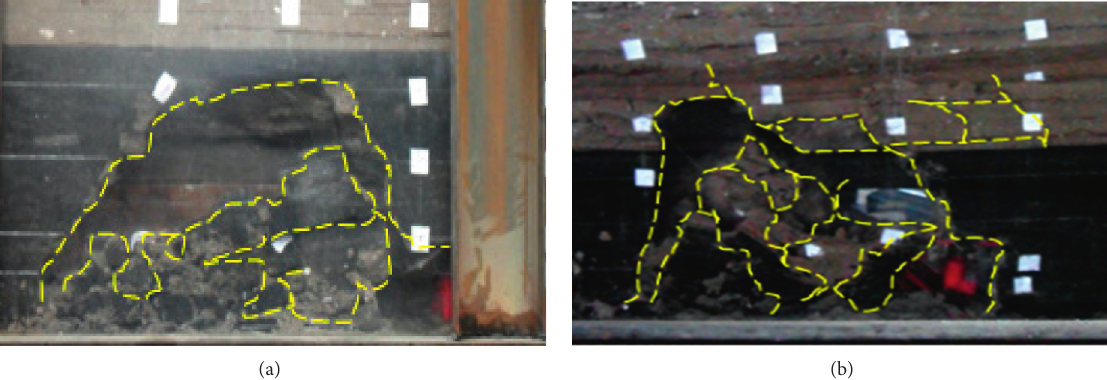
Figure 2: The first caving of top coal. (a) The mining height is 4 m and the working face is pushed 29.68m. (b) The mining height is 7.5m and the working face is pushed 22.08m.